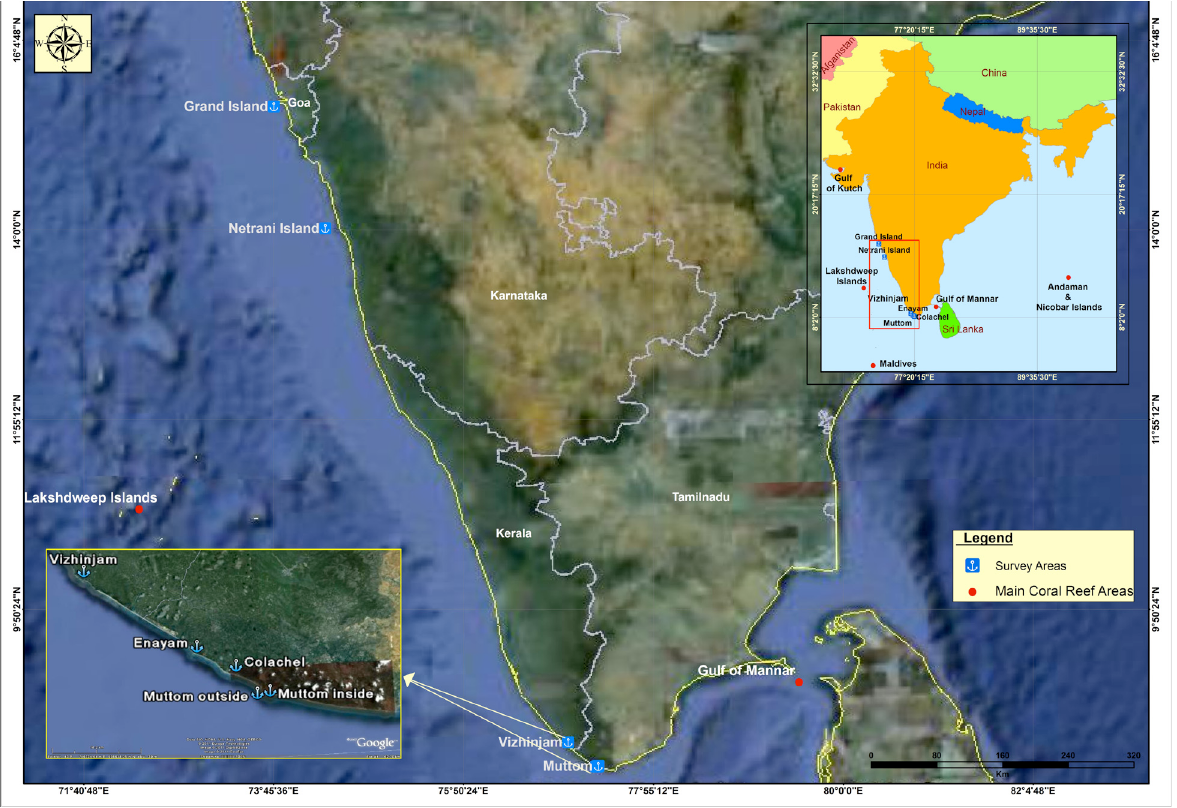
Image 1. Location of study sites along the west coast of